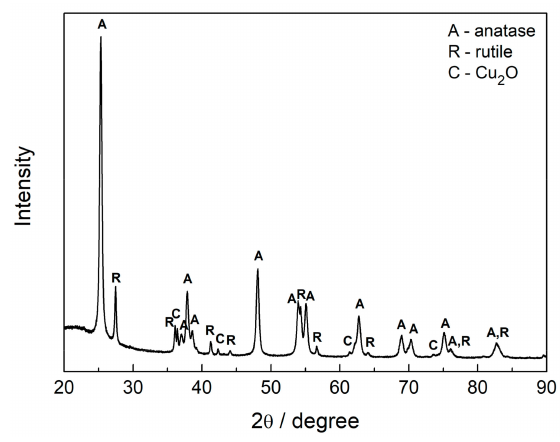
Figure 3. XRD diffractogram of Cu 2 O/PTr–TiO 2